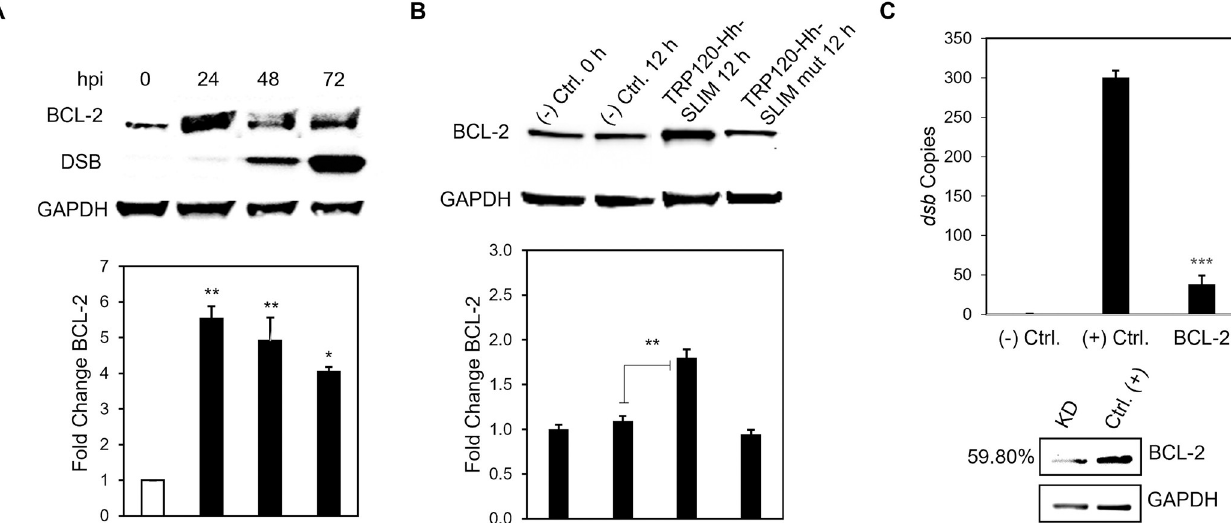
Fig 10. E . chaffeensis deploys the TRP120-Hh-SLiM to induce BCL-2 expression for survival. (A) Western blot analysis of BCL-2 levels of E . chaffeensis infected (MOI 100) THP-1 cells collected at 0, 24, 48 and 72 hpi with GAPDH as a loading control and Dsb as an infection control. E . chaffeensis induces BCL- 2 protein expression. (B) BCL-2 levels of TRP120-Hh-SLiM and TRP120-Hh-SLiM-mut treated and untreated THP-1 cells collected at 12 hpt with GAPDH as a loading control. The TRP120-Hh-SLiM peptide induces BCL-2 protein expression, but the mutant does not. (B, C) Bar graphs depict Western blot densitometry values normalized to GAPDH. (C) siRNA knockdown (KD) of BCL-2 significantly reduces E . chaffeensis infection in THP-1 cells as determined by qPCR amplification of the dsb gene. Scrambled siRNA (scrRNA) was transfected for positive (infected) and negative control (mock infected). Western blot depicts knockdown efficacy of siRNA in knockdown cells compared to the positive control. Number left of siRNA lane indicates percent knockdown of BCL-2 relative to positive control, normalized to GAPDH expression. (A-C) Experiments were performed with at least three biological and technical replicates and significance was determined through t -test analysis. Data are represented as means ± SD ( � p < 0.05; �� p < 0.01; ��� p < 0.001).